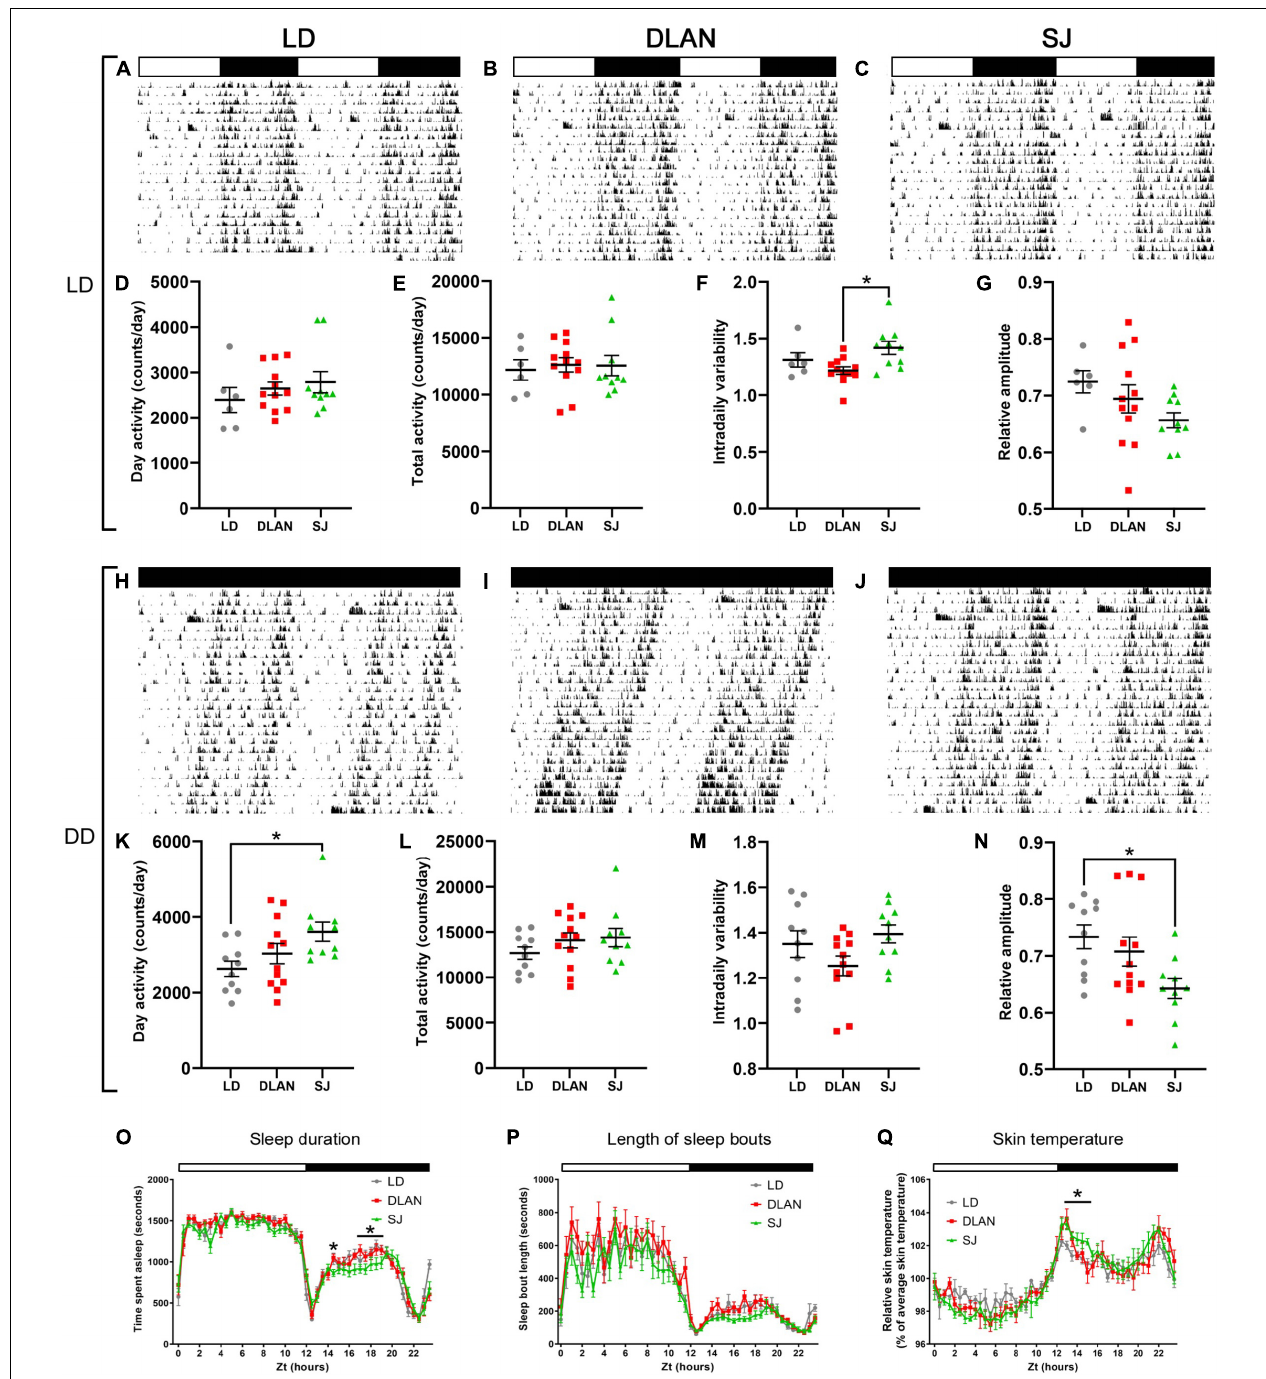
FIGURE 4 | Passive infrared recordings (PIR) of single-housed mice, following the end of the 12-month lighting disruption period. Representative actograms for each lighting condition (listed vertically: 12:12LD, DD) are shown for each group: LD (A,H) , DLAN (B,I) , and SJ (C,J) (see Figure 1 for a description of the three groups). Data are double plotted to facilitate visualization. Variables were analyzed over a period of 20 days in each condition, including activity during the (subjective) day (D–K) , total daily activity (E) , free-running period (L) , intradaily variability (F–M) and relative amplitude (G–N) . (O,P) Amount of time spent in immobility-defined sleep (O) and the length of immobility-defined sleep bouts (P) under LD (O) , for the three groups. (Q) Skin temperature under LD, for the three groups. (D–G,K–N) One-way ANOVA (with Welch correction, or Kruskal-Wallis test when appropriate), groups: LD, DLAN, SJ. Post-hoc tests conducted with Benjamini-Hochberg corrections when appropriate. Supplementary Table 2 lists the mean ± SEM of all analyzed parameters. (O–Q) Repeated measures ANOVA (with Welch correction), groups: LD, DLAN, SJ. Post-hoc tests conducted with Benjamini-Hochberg corrections. * p < 0.05.